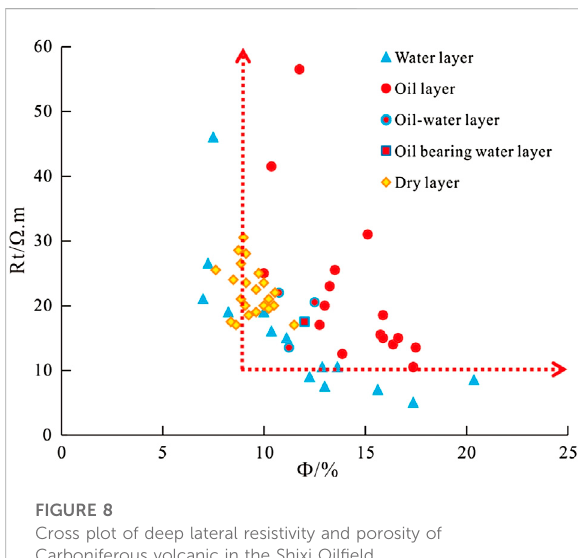
FIGURE 8 Cross plot of deep lateral resistivity and porosity of Carboniferous volcanic in the Shixi Oil fi